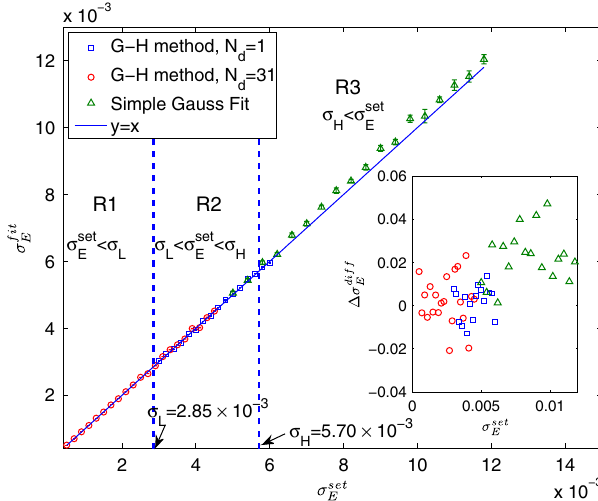
FIG. 4. (Color) A simulated spectrum and related fitted curves. FIG. 5. (Color) Comparison of the fitted and set values of the Parameters to generate simulated spectra are listed in Table I < (cid:1) set E < ), R2 ( (cid:1) energy spread in three regions: R1 ( (cid:1) set E < (cid:1) L L ¼ 1 , and (cid:3) ¼ 1 nm . The red solid with (cid:1) set E ¼ 5 : 00 (cid:2) 10 (cid:1) 3 , N d x (cid:1) ), and R3 ( (cid:1) set E > (cid:1) ). Parameters to generate simulated H H curve is a fitted spectrum using the G-H method; the black ¼ 1 nm . For small energy spectra are listed in Table I with (cid:3) x dashed curve is the fitted spectrum using the SES method. The ¼ 31 , and for large energy spread, N ¼ 1 . The G-H spread, N d d fitted values of the energy spread using both methods are listed in method is used to fit the spectra in both R1 and R2 regions; the the simple Gaussian fit is used for some spectra in the region R2 and all the spectra in the region R3. The inset shows the relative discrepancy between the fitted and set values of the energy spread in the three regions.